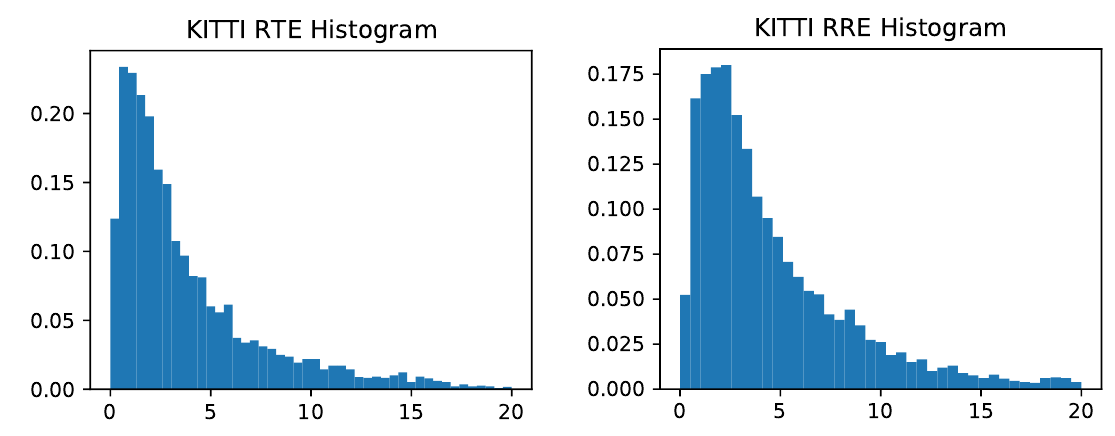
Figure 5. Histograms of image-point cloud registration RTE and RRE on the KITTI datasets. The x-axis is RTE (m) and RRE ( ◦ ), and the y-axis is the percentage.